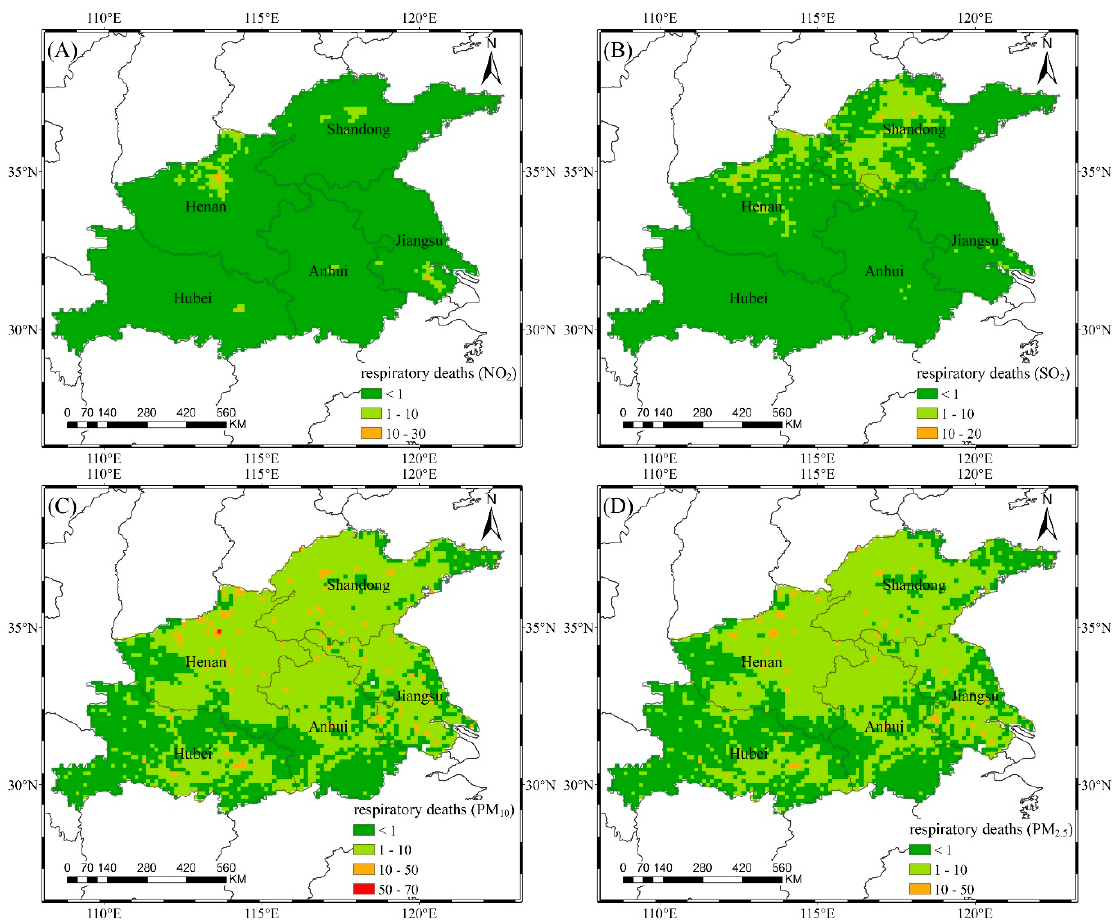
Figure 6. The number of respiratory deaths attributed to NO 2 ( A ), SO 2 ( B ), PM 10 ( C ), and PM 2.5 ( D